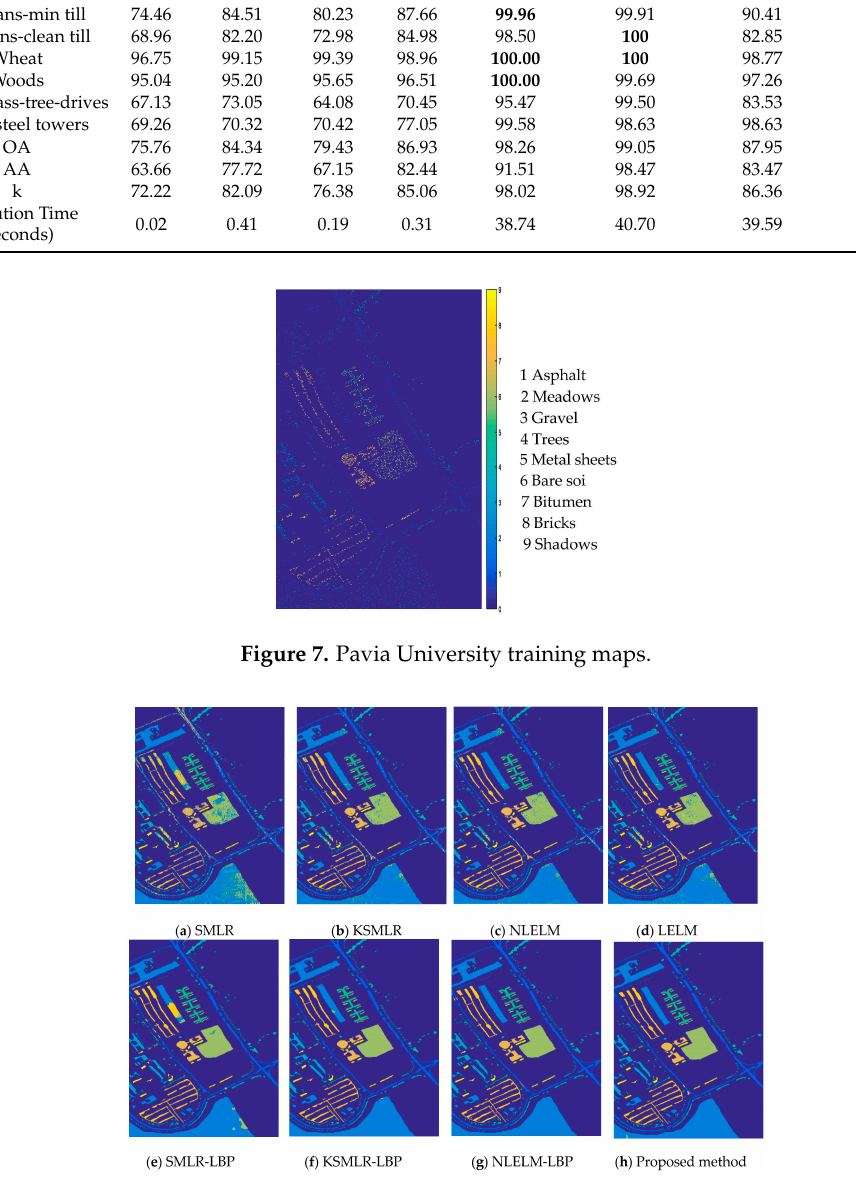
Figure 8. The overall accuracy of Pavia University image: ( a ) SMLR (OA = 78.78%); ( b ) KSMLR (OA = 93.00%); ( c ) NLELM (OA = 93.94%); ( d ) LELM (OA = 91.23%); ( e ) SMLR-LBP (OA = 95.68%); ( f ) KSMLR-LBP (OA = 99.42%); ( g ) NLELM-LBP (OA = 99.61%); ( h ) Proposed method (OA = 99.82%).